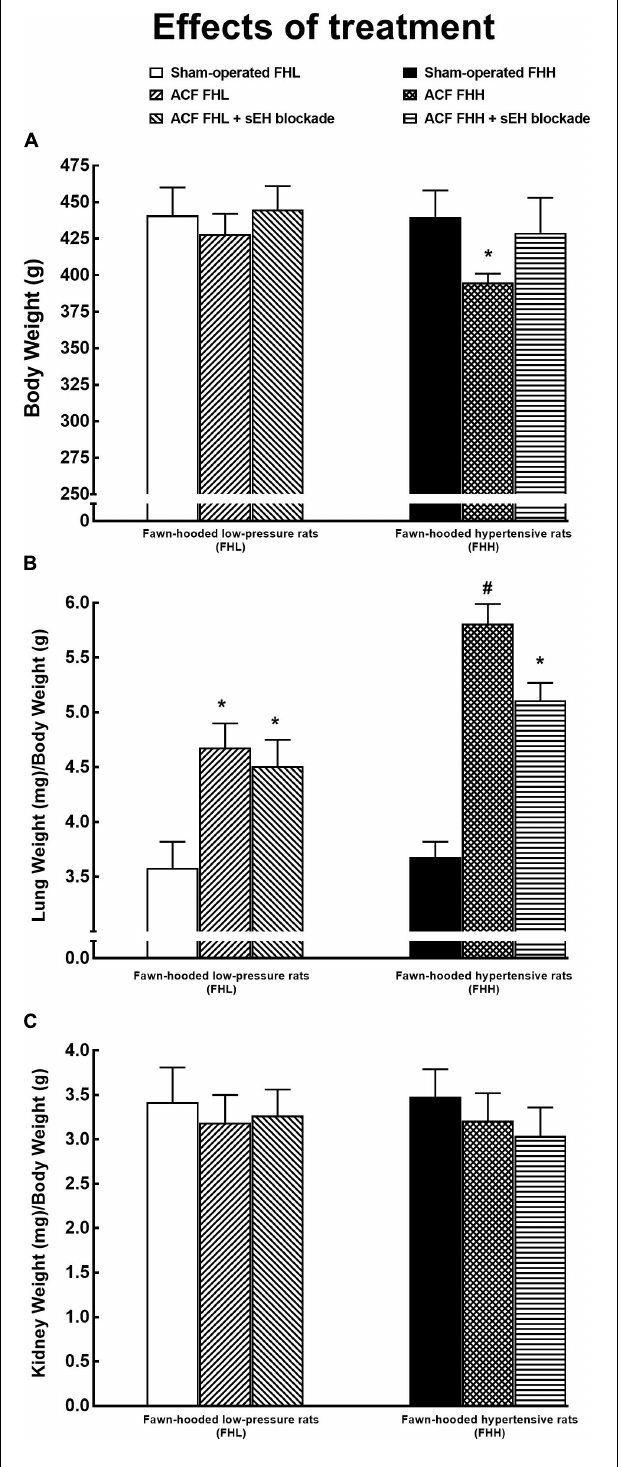
FIGURE 10 | Body weight (A) , lung weight (B) , and kidney weight (C) normalized to body weight in FHL and hypertensive (FHH) rats. The data for the groups of either strain that were sham-operated or with ACF, or ACF rats treated with a sEH inhibitor. ∗ P < 0.05 compared with the sham-operated counterparts. # P < 0.05 significant difference from ACF FHH rats treated with sEH inhibitor.